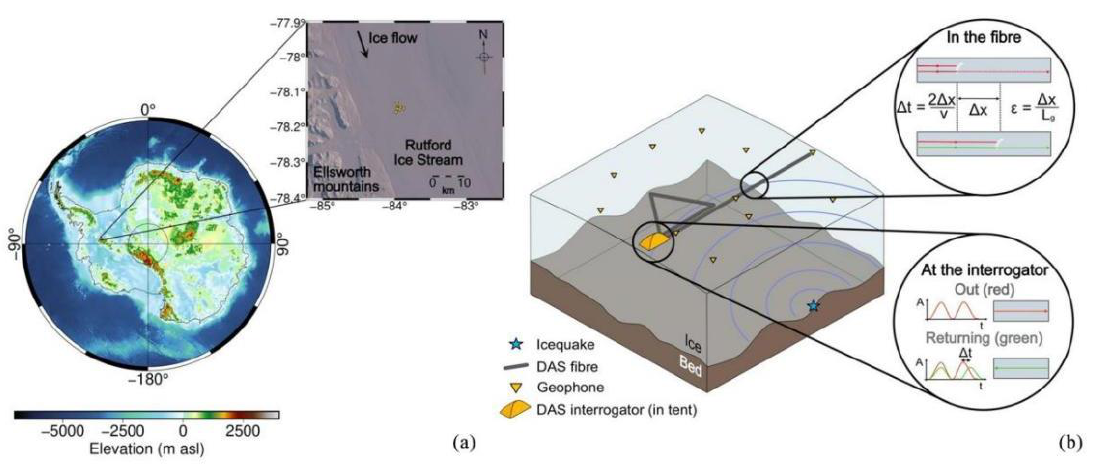
Figure 22. ( a ) Map and schematic showing experimental setup. ( b ) Schematic diagram of the experiment with the triangle and line fiber configurations [80].